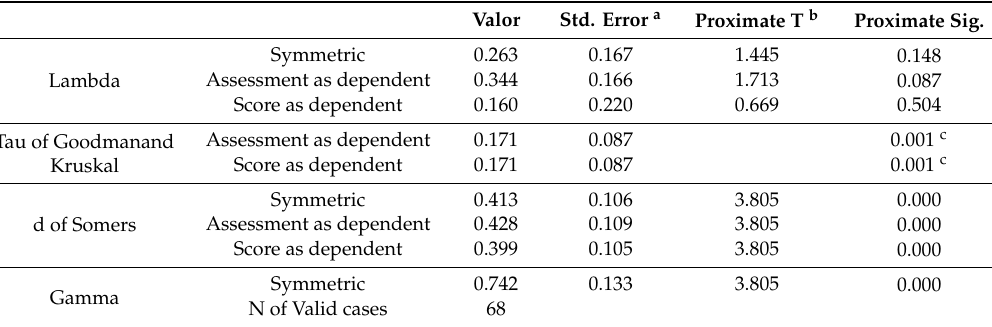
Table 14. Summary of di ff erent correlation